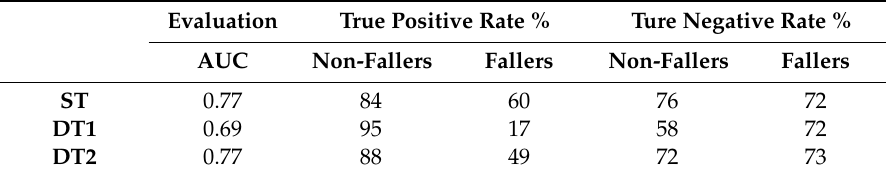
Table A1 indicates an overview of the PLS-DA fall classification evaluation results. Table A1. Results of PLS-DA classification for the single task (ST) a motor dual task (DT1) and a cognitive dual task